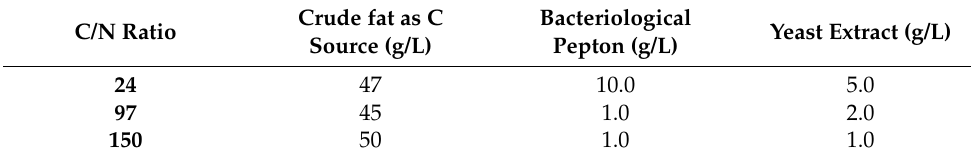
Table 2. Carbon and nitrogen sources from various materials at different C/N